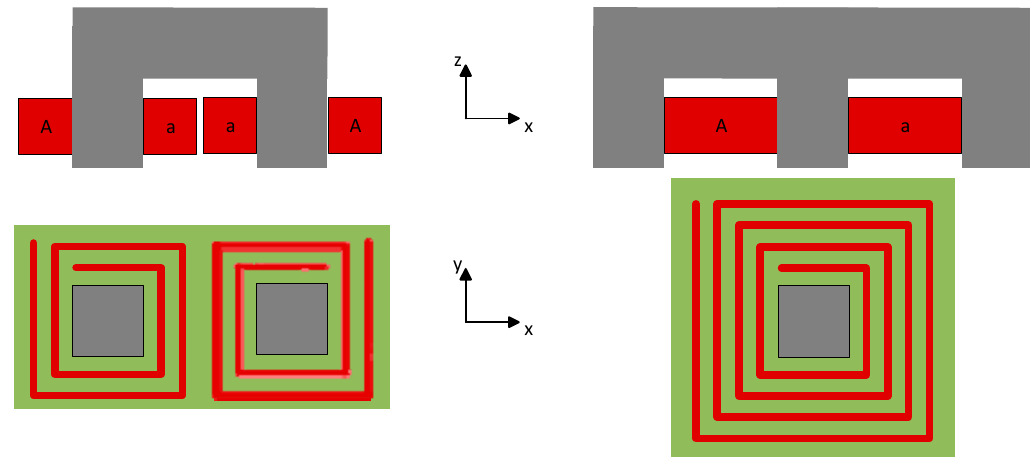
Figure 6. PCB arrangement and overall dimensions: double layer winding ( left ); single layer winding ( right ).